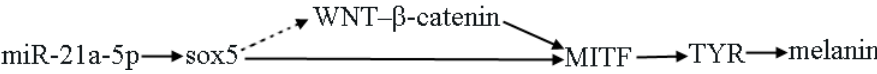
Figure 5. Potential pathway of miR-21a-5p in regulating melanogenesis in melanocytes of mouse.